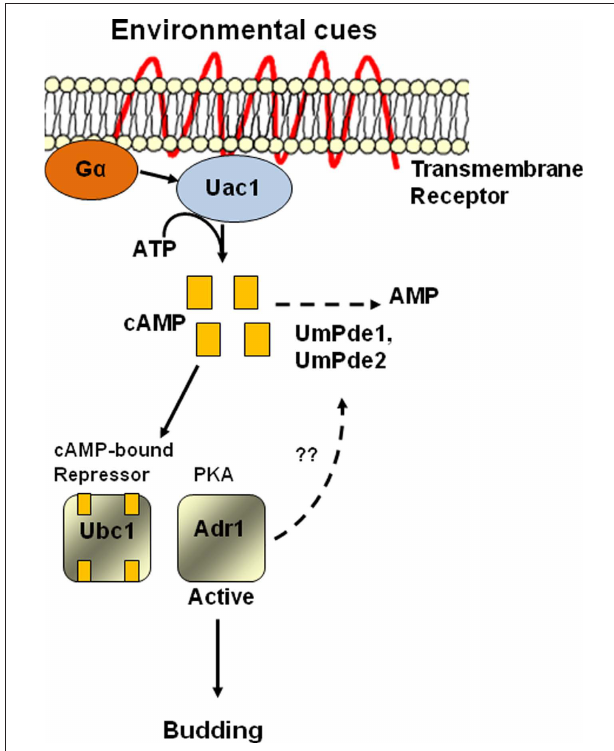
Figure 1 | Proposed model indicating roles of umPde1 and umPde2 in the cAMP signaling pathway. A morphogenic switch is regulated by the PKA pathway via several components. Adenylate cyclase (Uac1) is activated by G α -protein in response to environmental cues and converts ATP into cAMP. The cAMP binds with the regulatory subunit of PKA (Ubc1) causing it to dissociate from the catalytic PKA subunit. The active, derepressed catalytic subunit of PKA (Adr1) then targets downstream transcription factors and other proteins. UmPde1 and UmPde2 function to convert cAMP into AMP. This activity leads to continued repression of PKA activity due to Adr1 repression by Ubc1. Solid lines indicate known components of the pathway. The dashed line indicates a putative feedback regulation of UmPde1 and UmPde2 by phosphorylation through activated PKA. White squares of Ubc1 indicate unbound cAMP binding